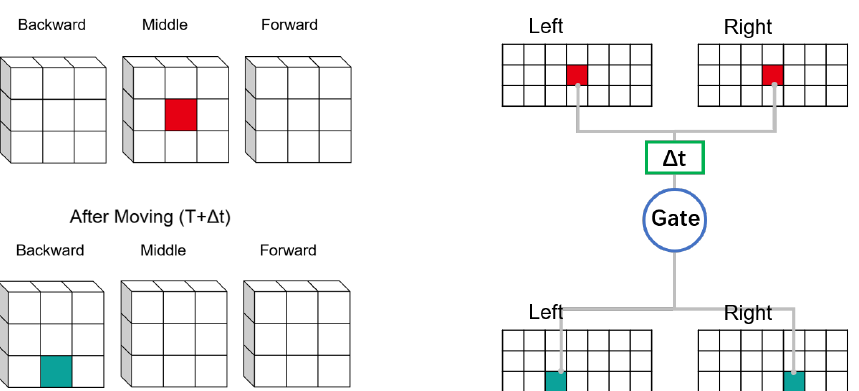
Figure 5. The position of the object in space ( Left ) and the projection of the object in the retina ( Right ), twenty-six local motion direction detection neurons are used to detect region from (1,1) to (3,7) over the two-dimensional retina receptive field. The red block represents the object before moving and the green block represents the object after moving. AND gate and delay channel are displayed in the right half of the